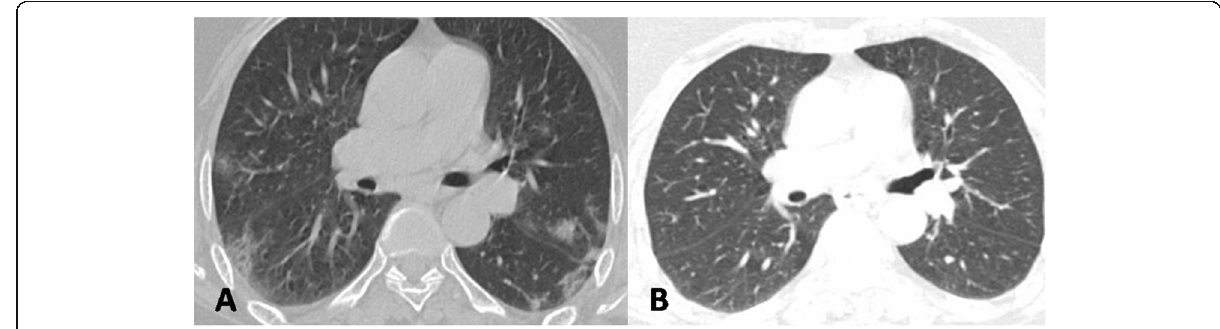
Fig. 1 Axial chest CT image in lung window settings of a 49-year-old COVID-19 patient showing multifocal subpleural ground glass opacities (GGOs) in both lungs at the time of hospital admission ( a ). Follow-up CT performed 93 days after the first CT reveals complete resolution